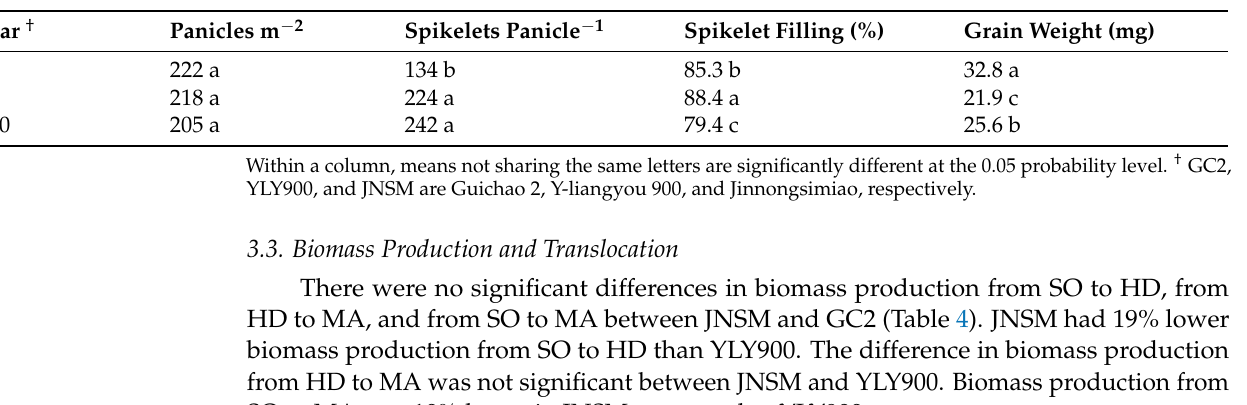
Table 3. Yield components of three rice cultivars across two years (2019 and 2020).